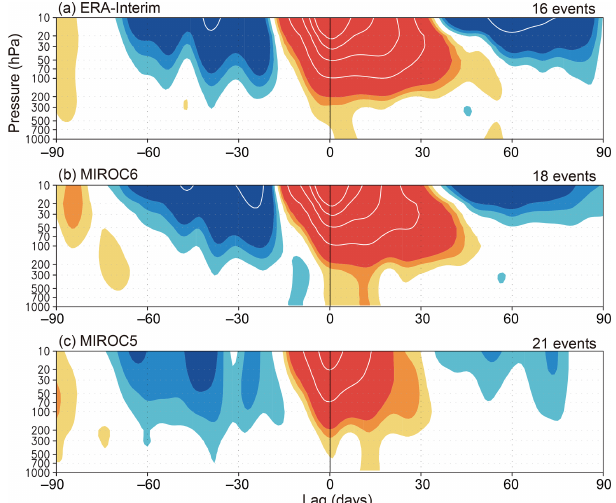
Figure 25. Composites of the time development of the zonal mean NAM index for stratospheric weak polar vortex events in (a) obser- vations (ERA-I), (b) MIROC6, and (c) MIROC5. The indices have dimensions of geopotential height (m), and red denotes negative val- ues. The color interval (contours) is 50m (400m). The number of events included in the composite is indicated above each panel.